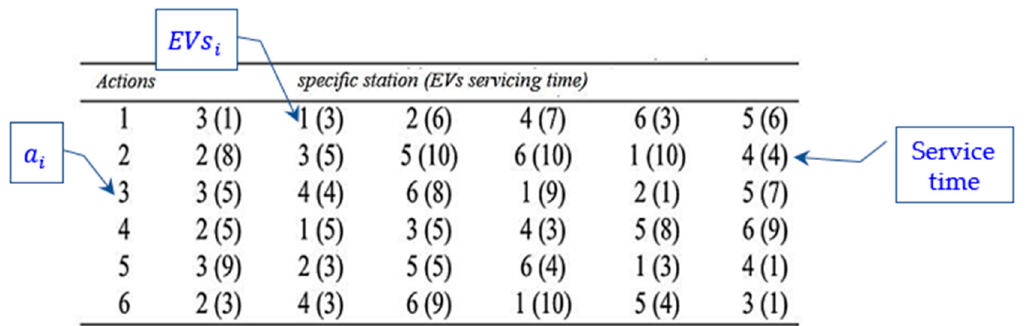
Figure 9. The queue of the EVs and their service time The DQN network was built for specific station δ 1 from three different stations δ i selected on the Zap Map and one of them meets the distance considerations discussed in Equations (4)–(10), and illustrated in Figure 10, to distribute the six different EVs to be served by the six actions a i until complete charging according to a specific policy π that selects a specific station δ i .